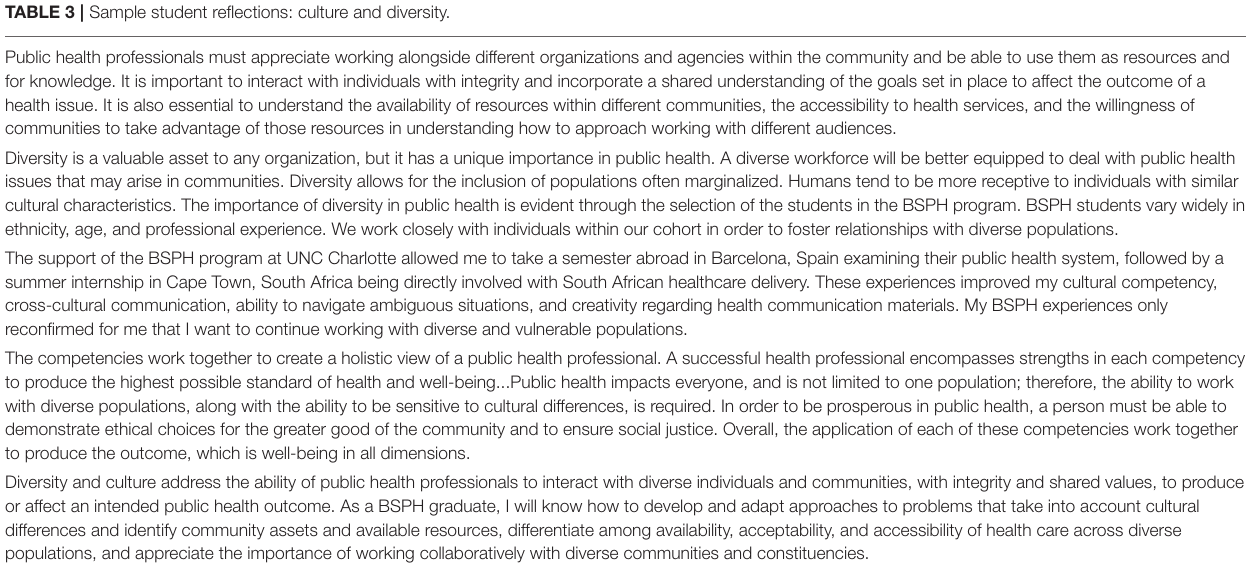
TABLE 3 | Sample student reflections: culture and